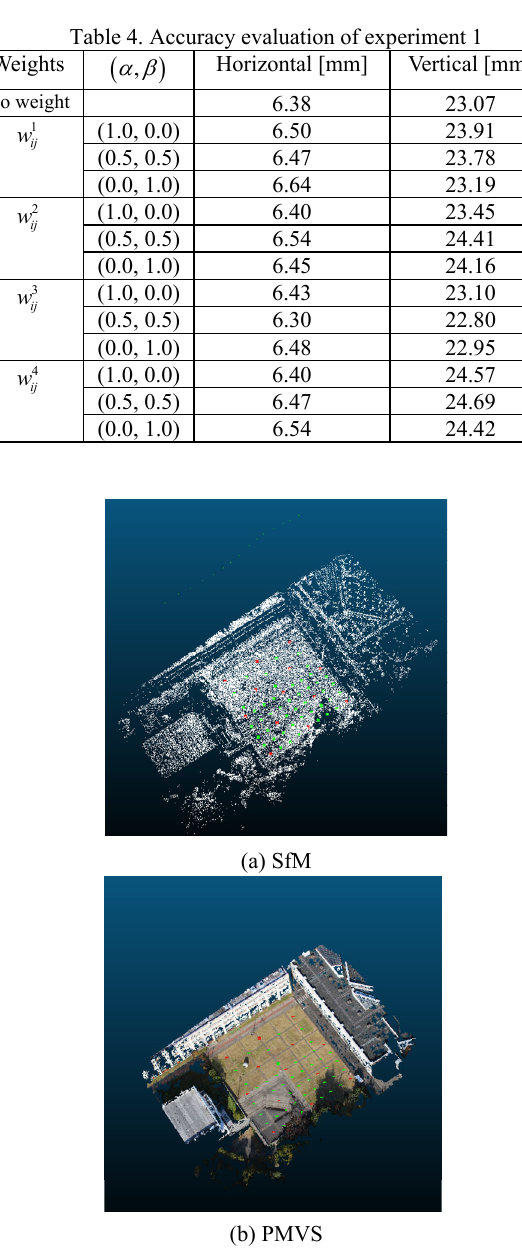
Figure 6. Result of UAV images